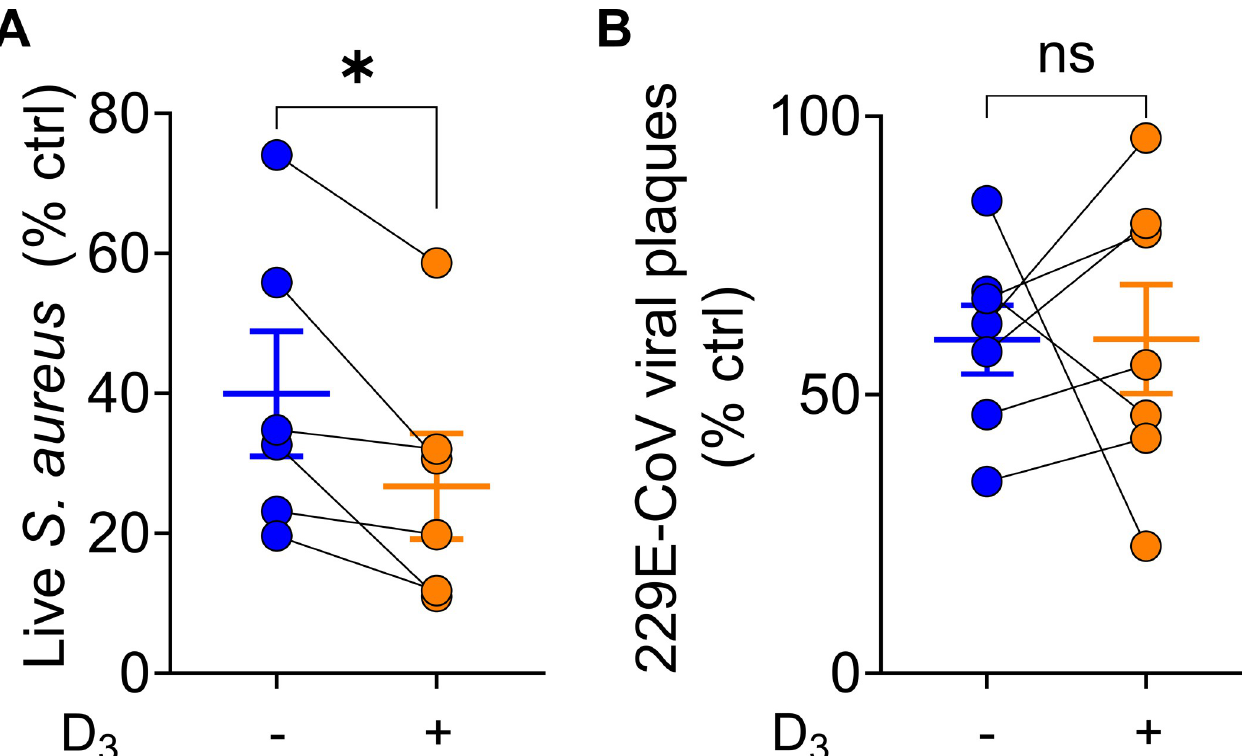
Fig 1. ASL bacterial and viral inactivation from paired hAECs untreated and treated with calcitriol. A. ASL from untreated (blue dots) and calcitriol- treated (orange dots) hAECs or vehicle control was challenged with bioluminescent S . aureus and RLUs were read within 12 minutes; individual points represent mean data from six individual experiments, ASL derived from 4–6 individual hAEC donors, � indicates p < 0.05 B. ASL from untreated (blue dots) and calcitriol-treated (orange dots) hAECs compared to vehicle control. Conditions were challenged with 229E-CoV in MRC-5 human fibroblasts, and viral plaques quantified. Individual points represent mean data from seven individual experiments, ASL was derived from 4–6 individual hAEC donors; raw plaque values for control, untreated hAEC ASL, and supplemented hAEC ASL were compared by a paired Friedman test, ASL vs. vehicle control p < 0.01, ASL from hAECs supplemented with calcitriol vs. vehicle control p = 0.049, treated vs. untreated ASL p > 0.99. All studies were performed in triplicate and error bars represent mean ±